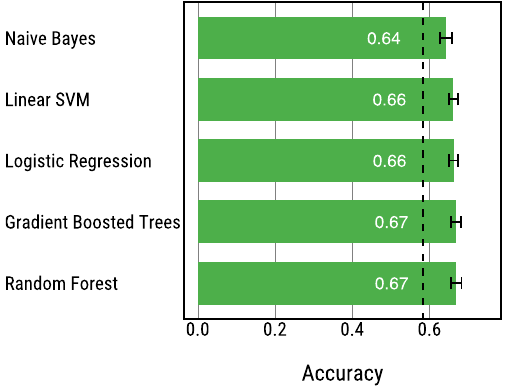
Figure 3. Accuracy of five off-the-shelf machine learning algorithms at predicting whether a group will escape the room computed using nested 10-fold cross-validation. The error bars show 95% confidence intervals computed over the 10-folds of the data. The dashed black line shows the accuracy of a dummy classifier that always predicts the most frequent class in the training data.